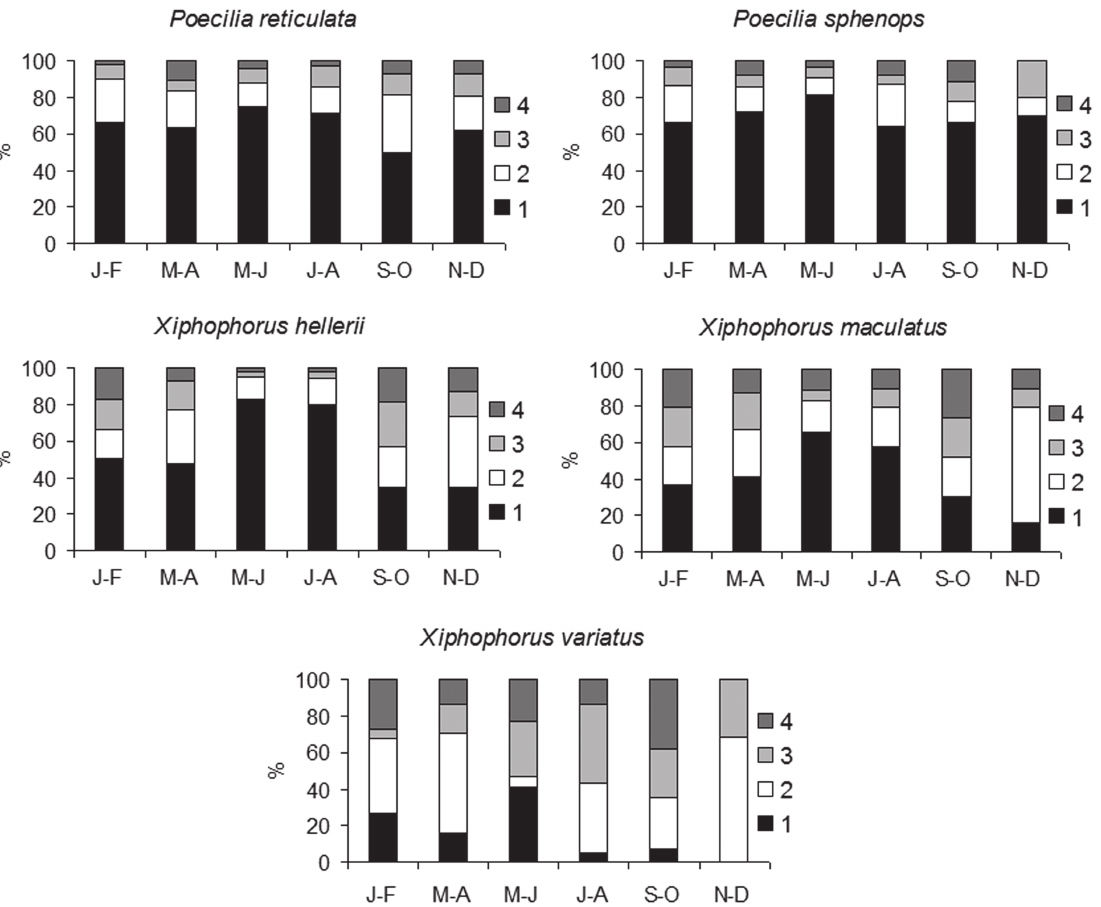
Fig. 5. Relative bimonthly frequency of developmental stages in ornamental non-native poeciliid females collected in Chato Creek, 2006. Developmental stages: 1 Non-gravid, 2 Yolked ova, 3 Eyed embryos, 4 Mature embryos.